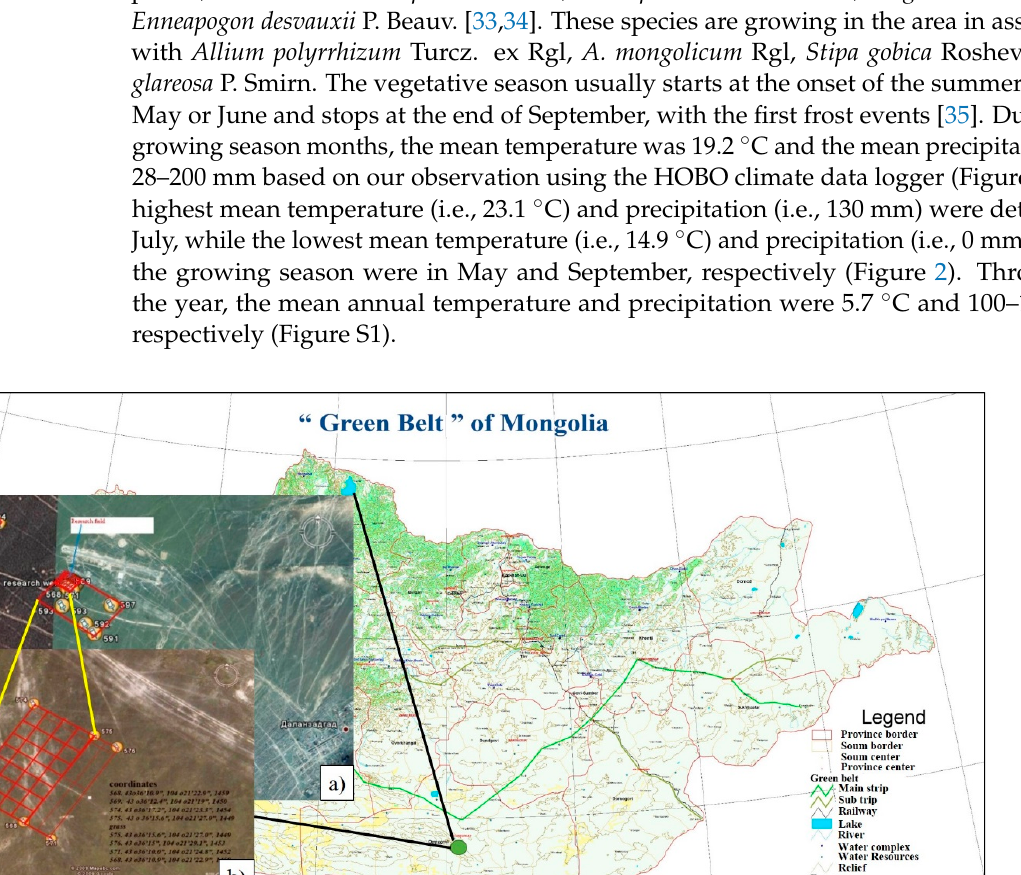
Figure 2. Mean monthly air temperature (solid line) and precipitation (broken, dotted line) in the experimental site during the growing season (i.e., May–September 2009–2019). 2.2. Experimental Design We used two-year-old nursery-grown seedlings of four different woody species, namely, Tamarix ramosissima Ldb., Ulmus pumila L., Elaeagnus moorcroftii Wall. ex Schlecht., and Hippophae rhamnoides L. The initial root collar diameter (RCD) and the height of the 576 seedlings of the four species were measured (Table 1). Thereafter, they were planted